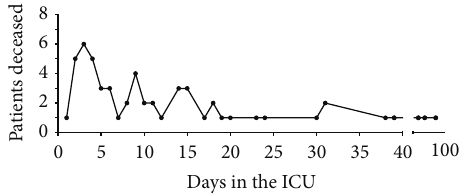
Figure 2: Number of patients deceased per ICU day. There is a concentration of fatalities in the first 6